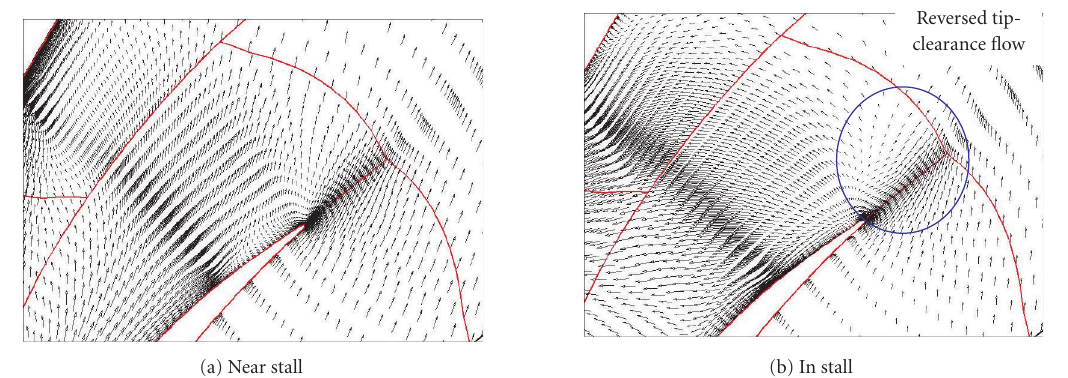
Figure 11: Comparison of velocity vectors (99% blade